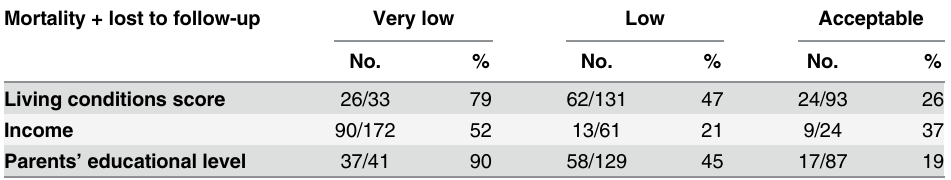
The proportion of children with CKD stage IV and V at the first visit (141/257) is possibly the most synthetic clinical expression of the unmet need of timely access to medical care in an LIC environment. The specific impact of the three main socioeconomic indicators on the com- bined end-point of mortality and lost to follow-up is shown in Table 4, which clearly docu- ments the steep gradients across the stratification levels, as well as a lower discriminatory yield of the "income" variable. Table 4. Socioeconomic factors as related to the cumulative outcome of mortality and lost to follow- up. Mortality + lost to